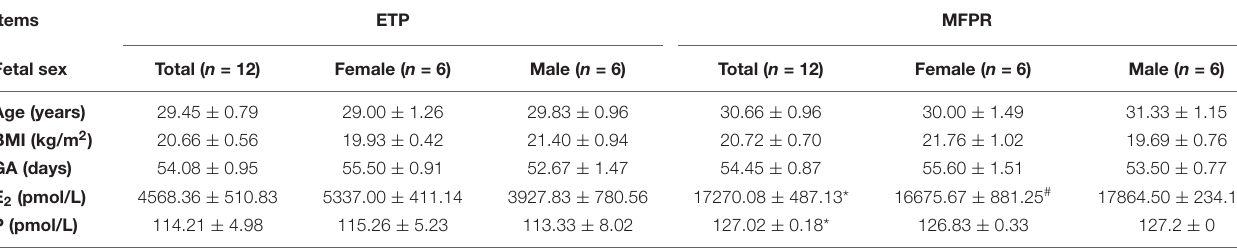
TABLE 1 | Clinical baseline characteristics of the patients from whom fetal tissue DNA was derived.